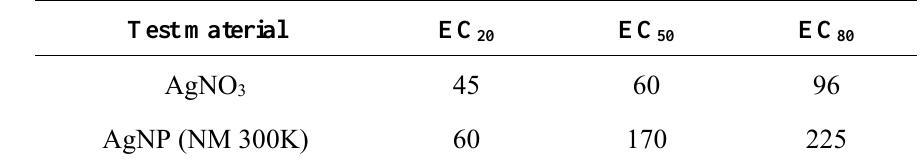
Table 1. Test exposure concentrations of AgNO 3 and AgNP, corresponding to the estimated reproduction effect concentrations (ECs), expressed as mg Ag / kg soil dry